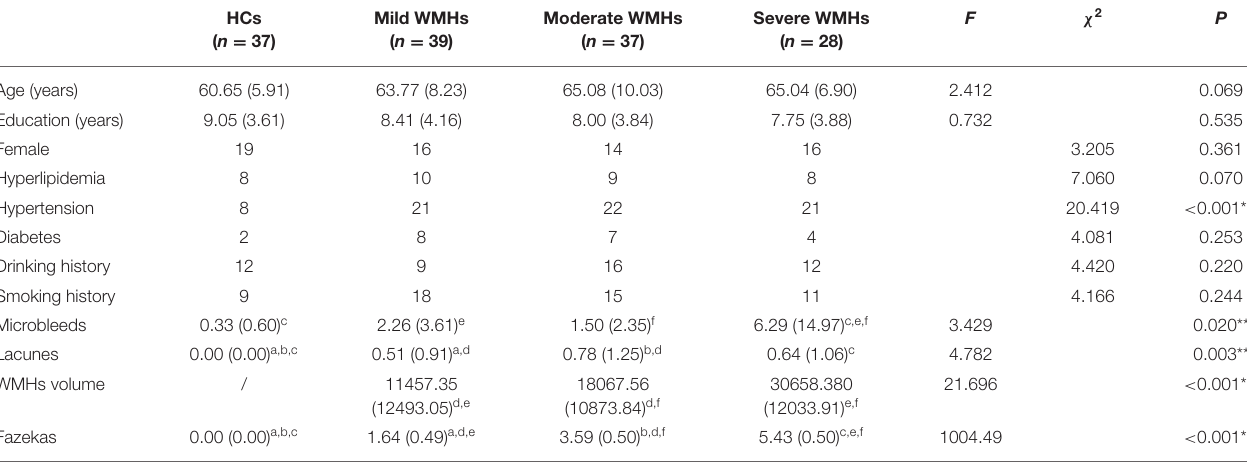
TABLE 1 | Demographic and WMHs neuroimaging manifestations of participants in the four groups [Mean